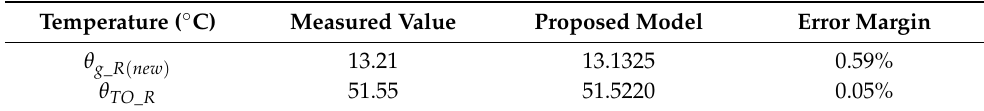
Table 8. Case study 1: 40 MVA 88/11 kV distribution transformer.